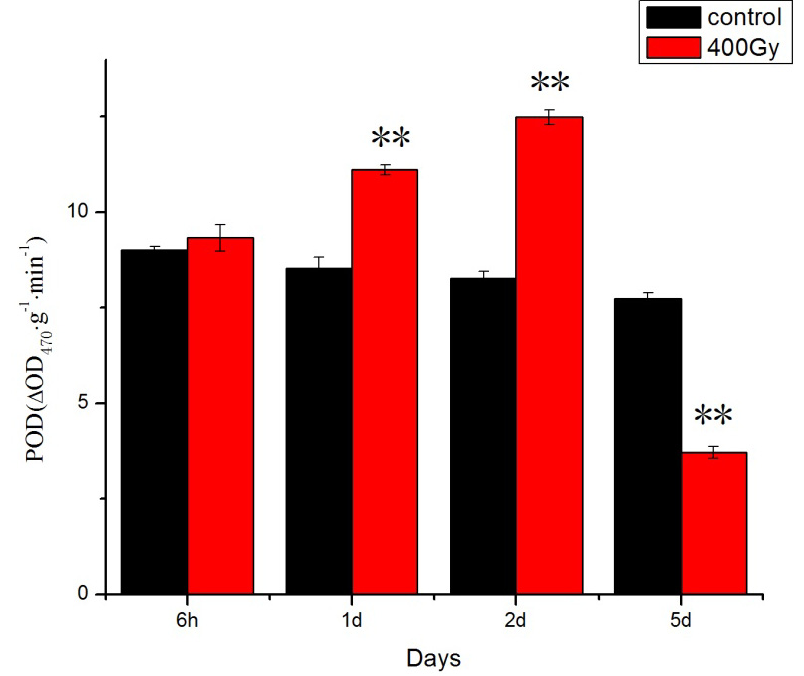
Figure 3. Effects of 60 Co- γ irradiation on POD activity of P. citri adults for different lengths of time. Values are mean ± SD ( n = 3). Asterisk designates statistically significant difference between control and irradiated adults (** p < 0.01).